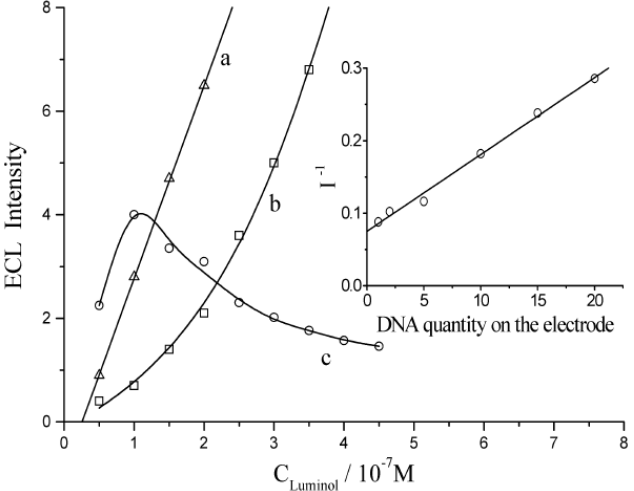
Figure 5. The ECL responses of luminol on (a) bare GC electrode and (b) dsDNA modified electrode. Curve (c) is the multiples of (a) to (b) . Insert is the regression curve of the reciprocal of ECL intensity (I − 1 ) versus the adsorptivd dsDNA quantity. Here the